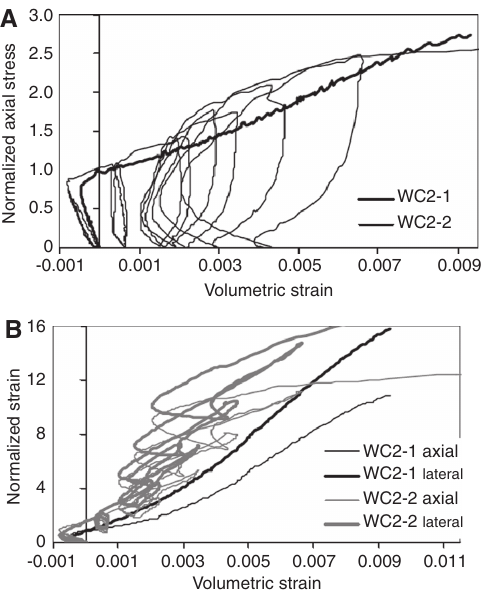
Figure 7 WC3 specimens: (A) normalized axial stress versus volu- metric strain, (B) normalized strain versus volumetric strain.